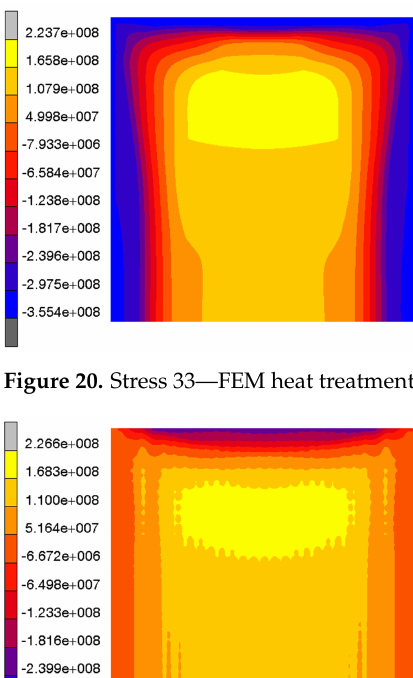
Figure 19. Stress 22—FE heat treatment.